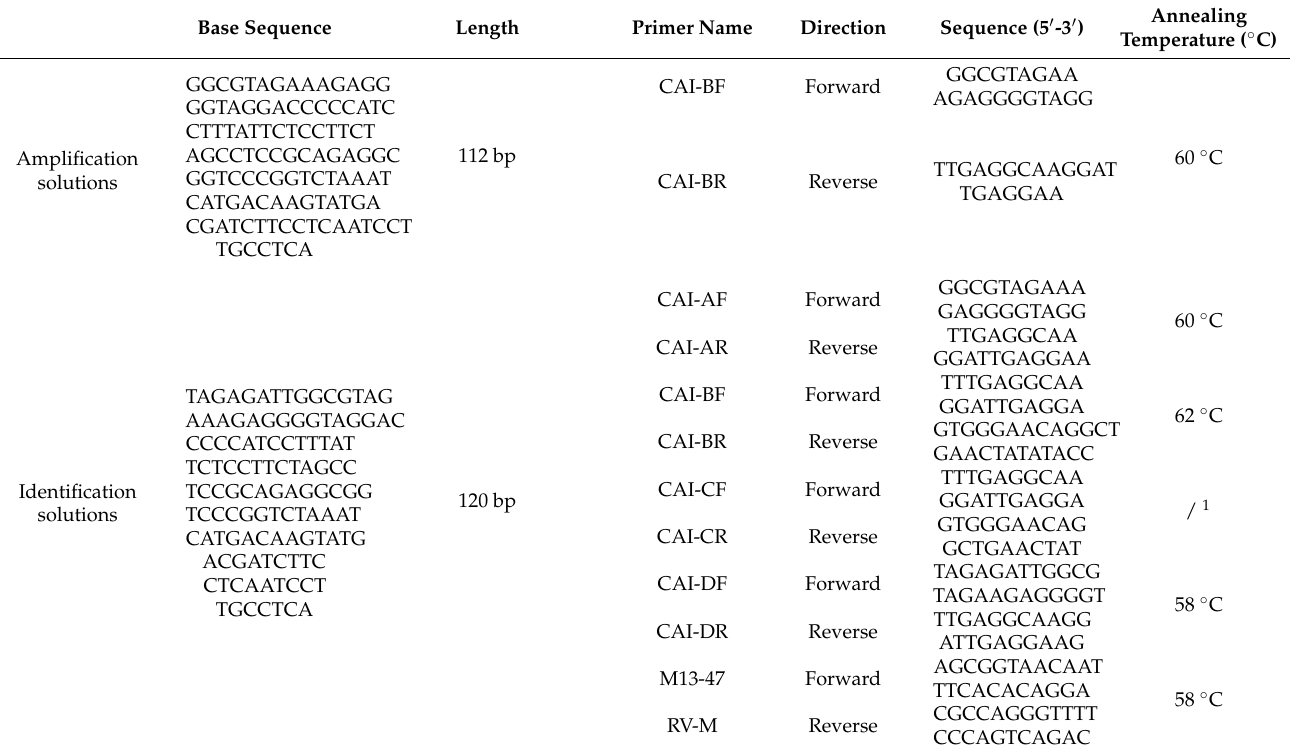
Table 1. DNA-traceable barcode amplification and identification